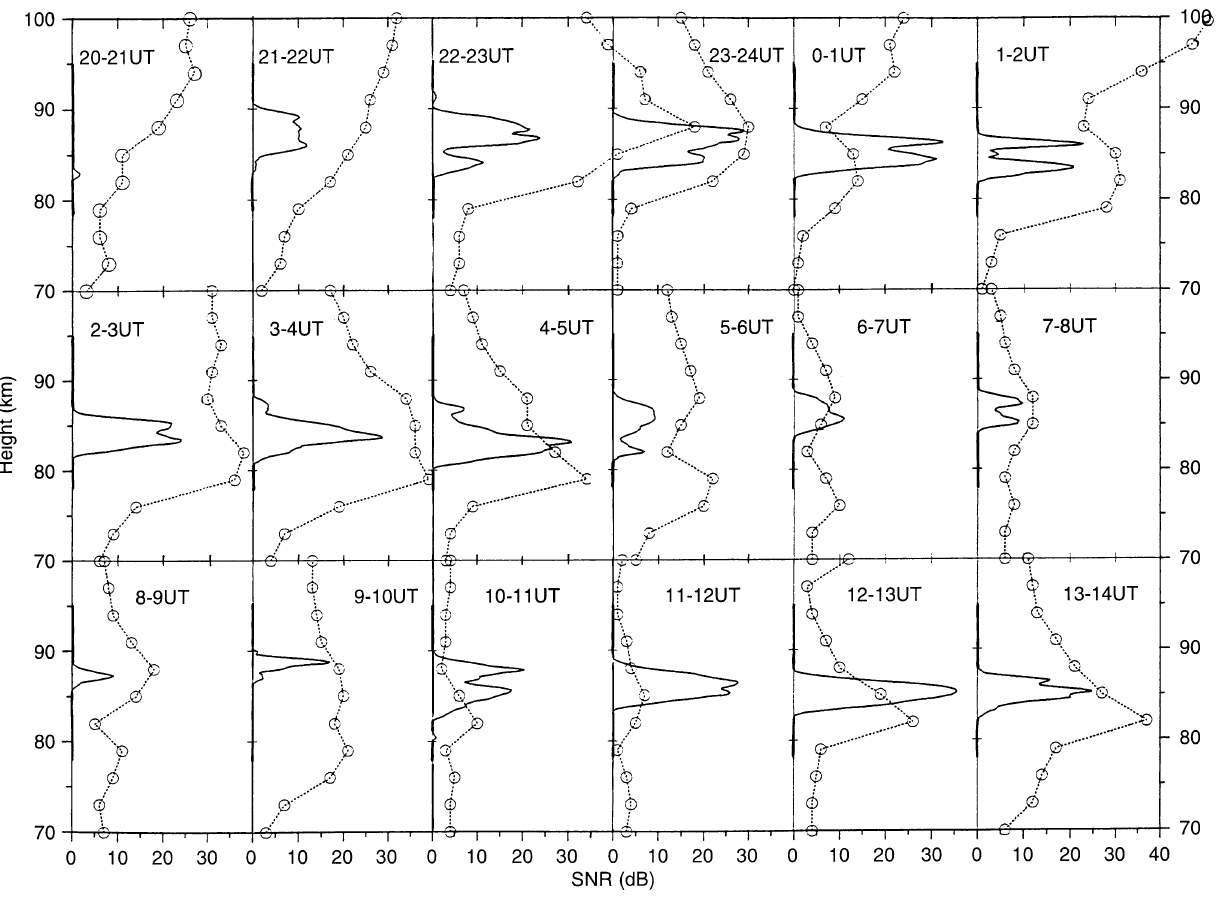
Fig. 5. Mean hourly SNR profiles deduced from ALOMAR SOUSY ( solid lines ) and MF-radar observations ( dotted lines ) on 28 — 29 July 1994